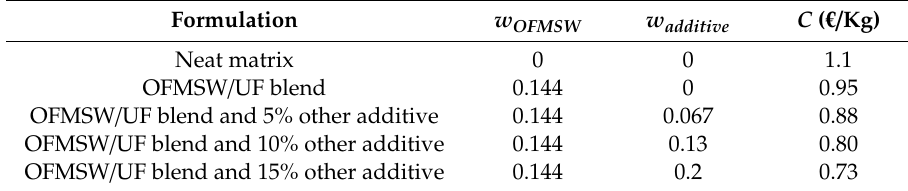
Table 6. Total cost balance for the production of the OFMSW / UF blends. Formulation w OFMSW w